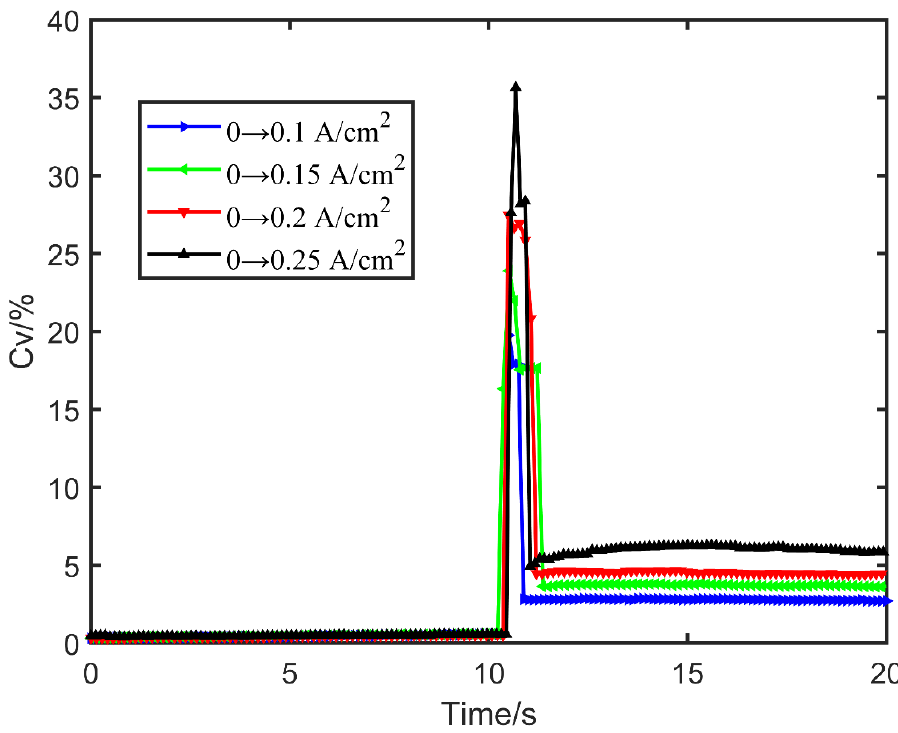
Figure 3. Evolution of voltage uniformity at different loading current densities.